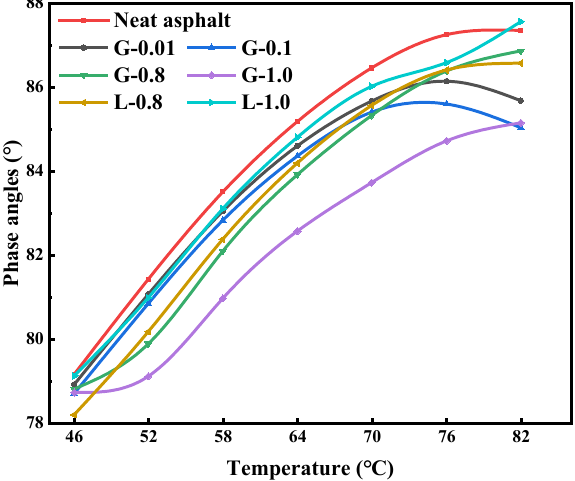
Figure 3. The phase angles of asphalts and mastics. Table 4. Continuous grading high temperature.